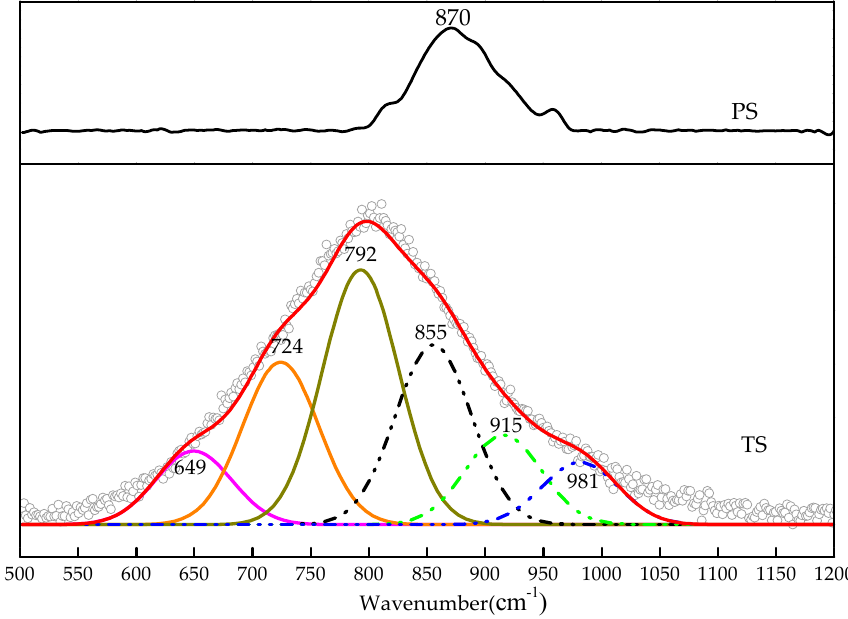
Figure 5. Raman spectroscopy of two kinds of water-quenched slag.